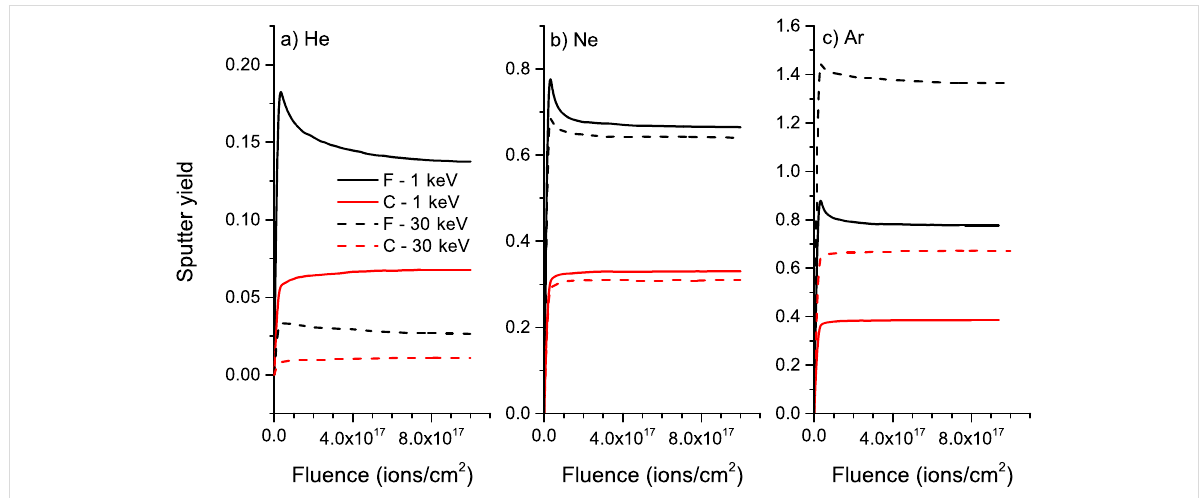
Figure 8: Evolution of sputter yields with fluence for a) helium, b) neon, and c) argon bombardment of PTFE at 1 keV and 30